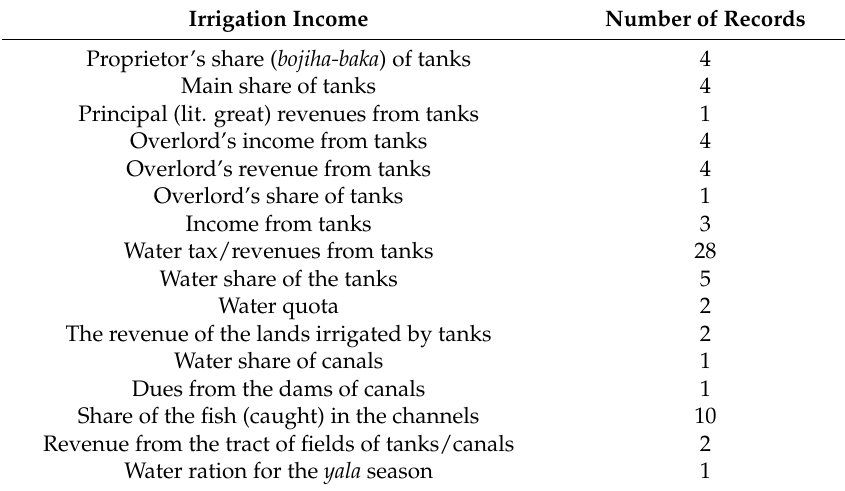
Table 6. Categories of irrigation incomes mentioned in ancient